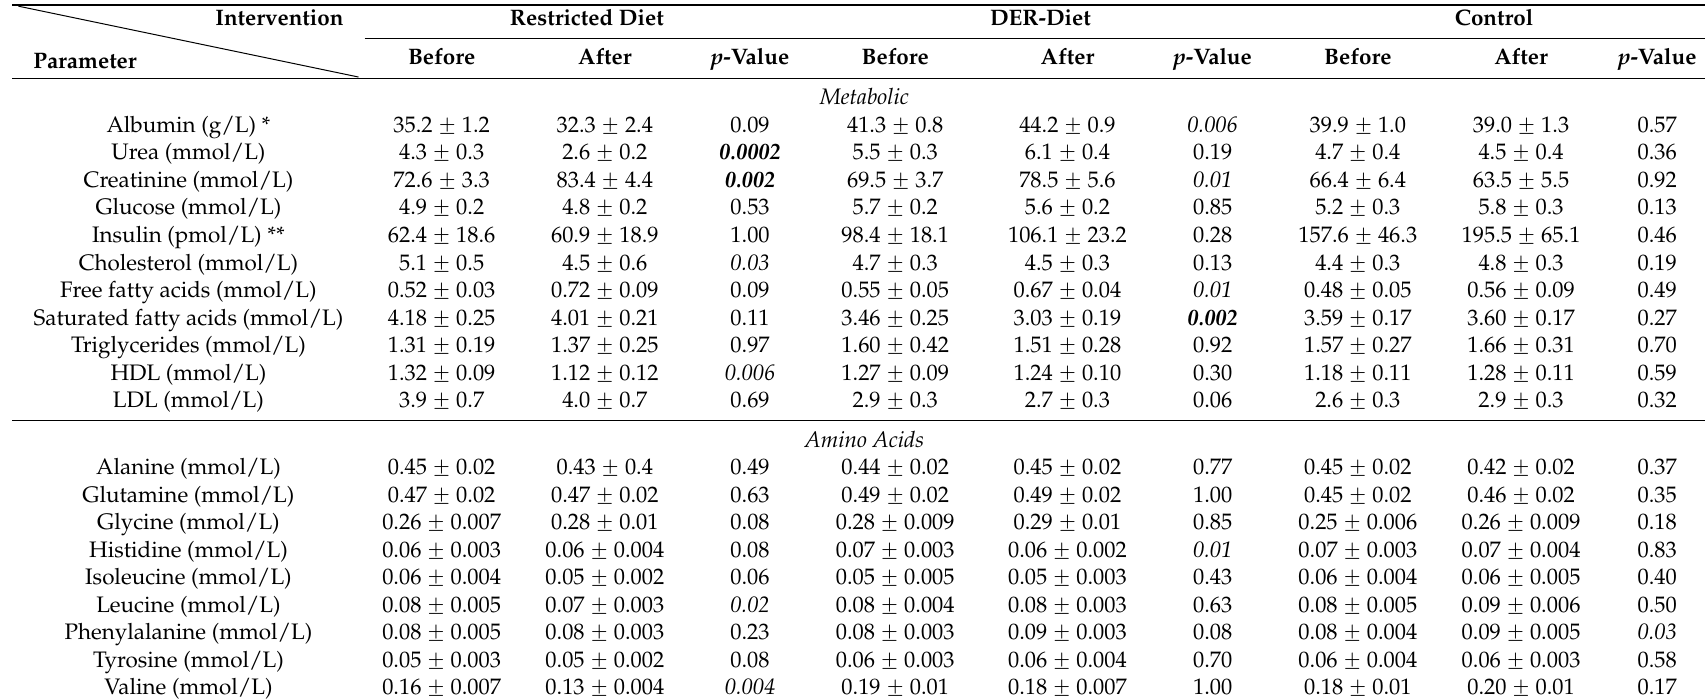
Table 3. Changes in metabolic parameters after the dietary intervention